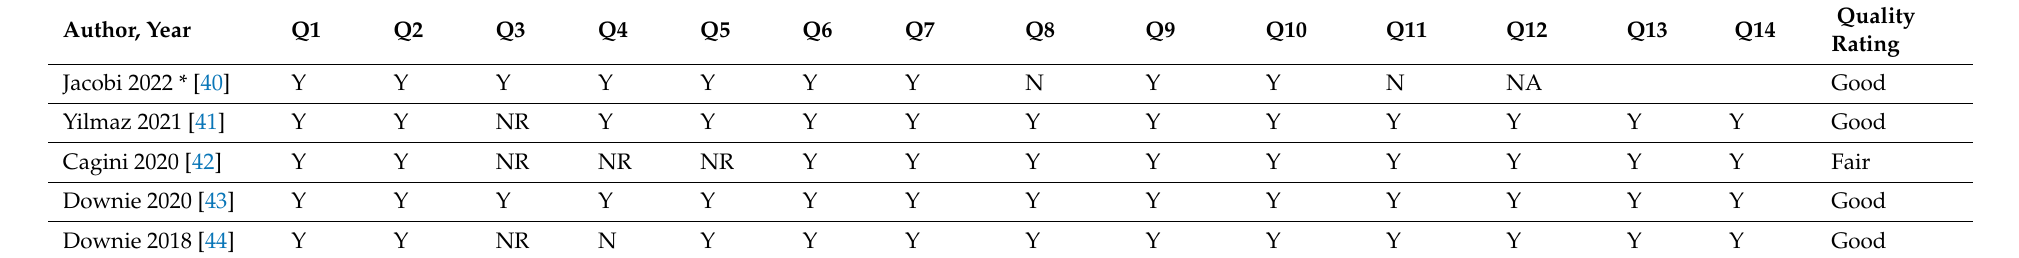
Table 4. Risk of bias (ROB2) assessment for human